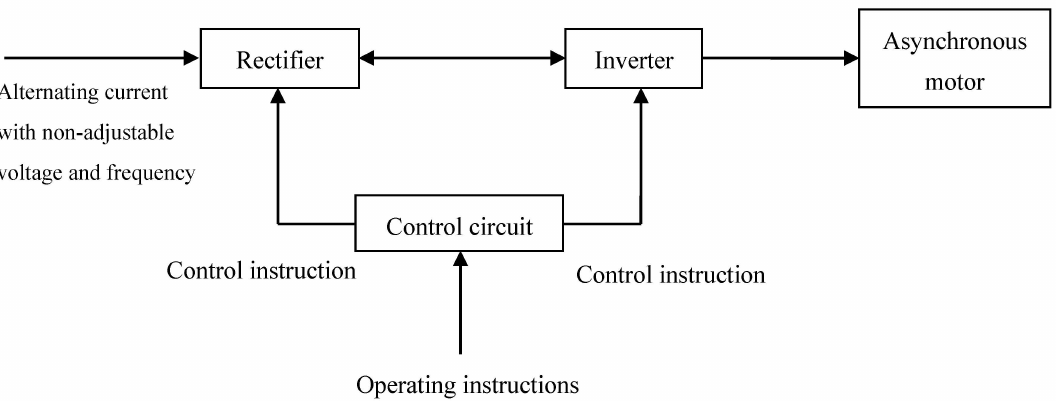
Figure 2. Flow chart of frequency converter